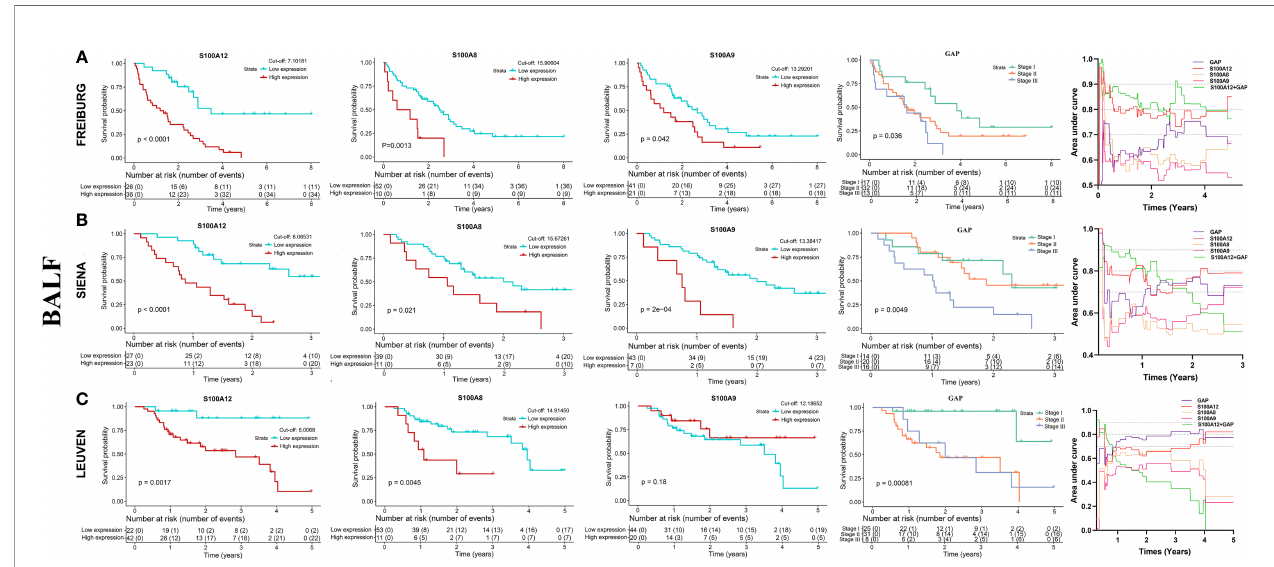
FIGURE 6 | K – M analysis and the predictive value of S100A12, S100A8, S100A9 and GAP index for the survival in the BALF of patients with IPF according to GSE70866 dataset. (A) FREIBURG cohort, (B) SIENA cohort, (C) LEUVEN cohort. The acquisition of composite variable such as S100A12 + GAP was based on the multivariable Cox